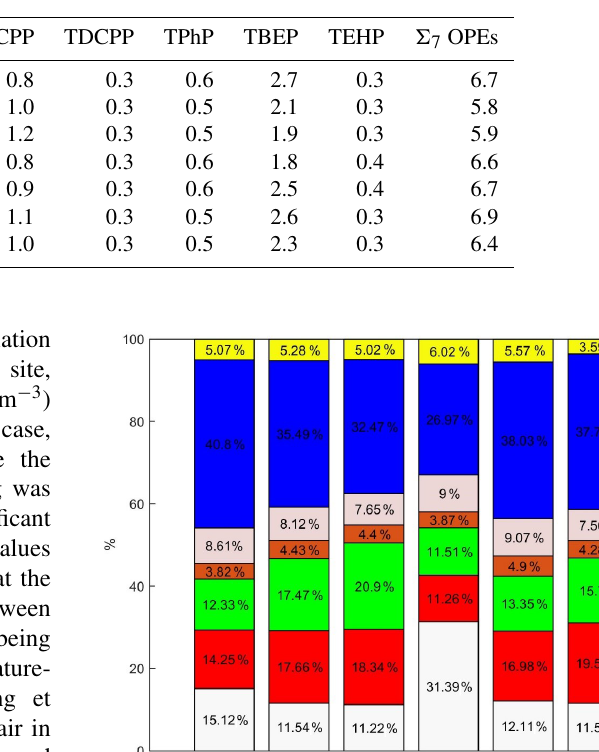
Table 1. The annual median concentrations of OPEs in PM 2 . 5 from Chengdu (ngm − 3 ).